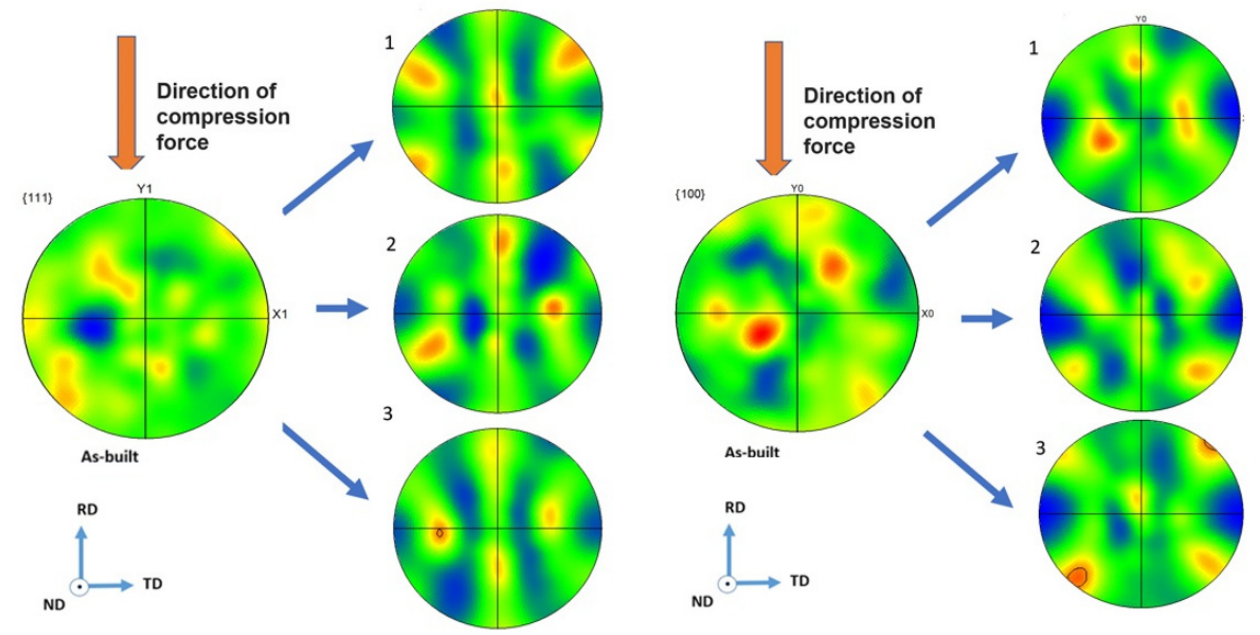
Figure 7. Pole figure with {100} and {111} zones obtained in studied samples after deformation with different strain rates, EBSD analysis: (1)—8 × 10 − 4 s − 1 , (2)—3 × 10 − 3 s − 1 , and (3)—2 × 10 − 2 s − 1 .